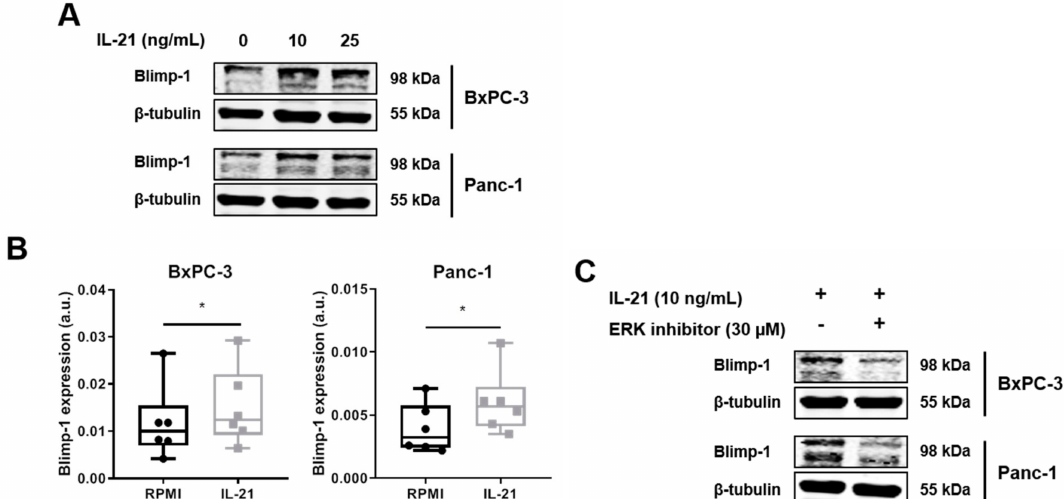
Figure 5. IL-21 upregulates Blimp-1 in an ERK-dependent manner. BxPC-3 and Panc-1 were incubated with IL-21 (10 and 25 ng / mL) for 24 h. ( A ) Treatment with IL-21 upregulates Blimp-1 expression. One of six independent experiments is shown. ( B ) Quantification of IL-21-dependent Blimp-1 upregulation (IL-21: 10 ng / mL). * P < 0.05. Wilcoxon rank-sum test. ( C ) ERK inhibitor prevents IL-21-dependent Blimp-1 upregulation. One of five independent experiments is